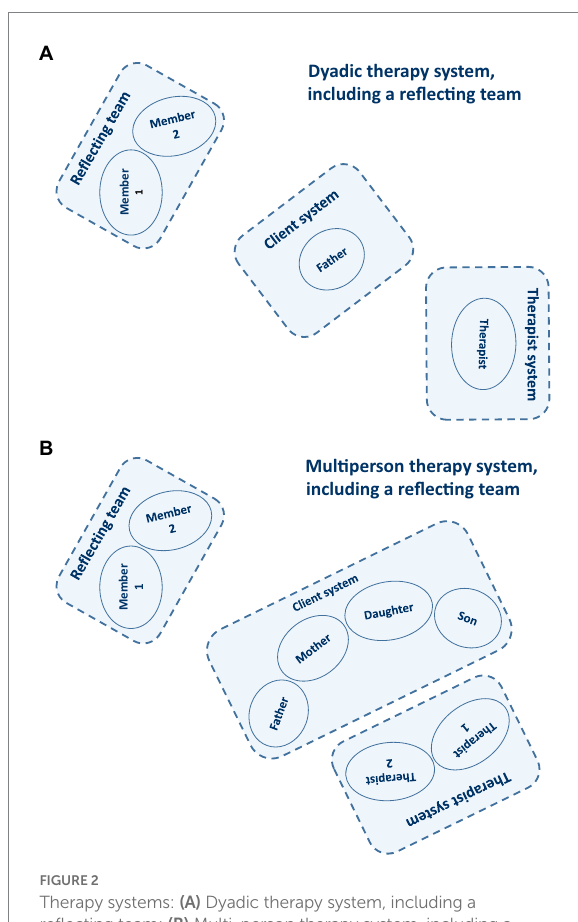
FIGURE 2 Therapy systems: (A) Dyadic therapy system, including a reflecting team; (B) Multi-person therapy system, including a reflecting team (Hunger,